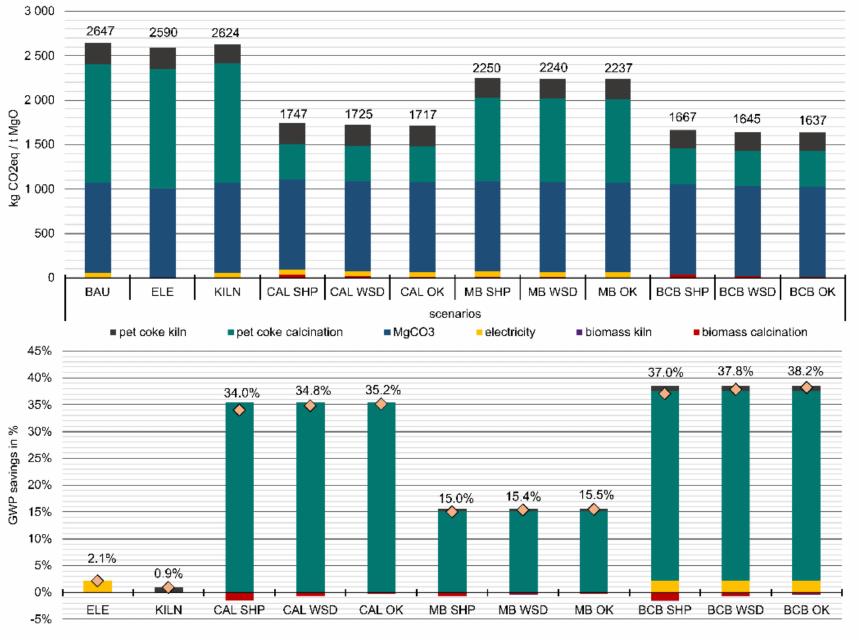
Figure 10. GWP of 1 ton of DBM MgO ( upper figure) and relative GWP savings against business-as- usual scenario ( lower figure) based on scenario description of Table